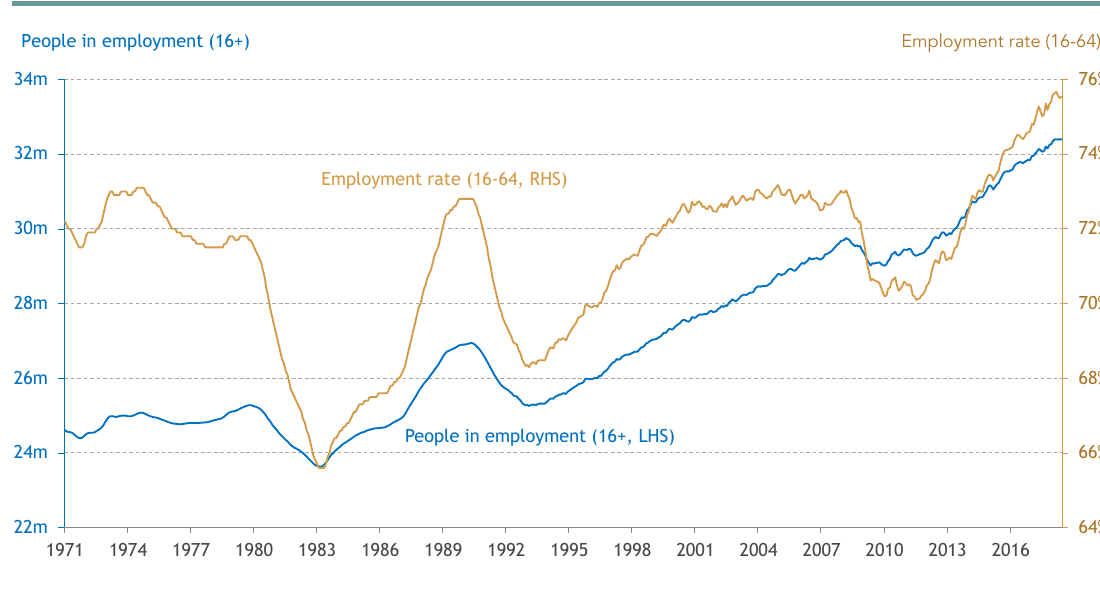
Source: RF analysis of ONS, Labour Market